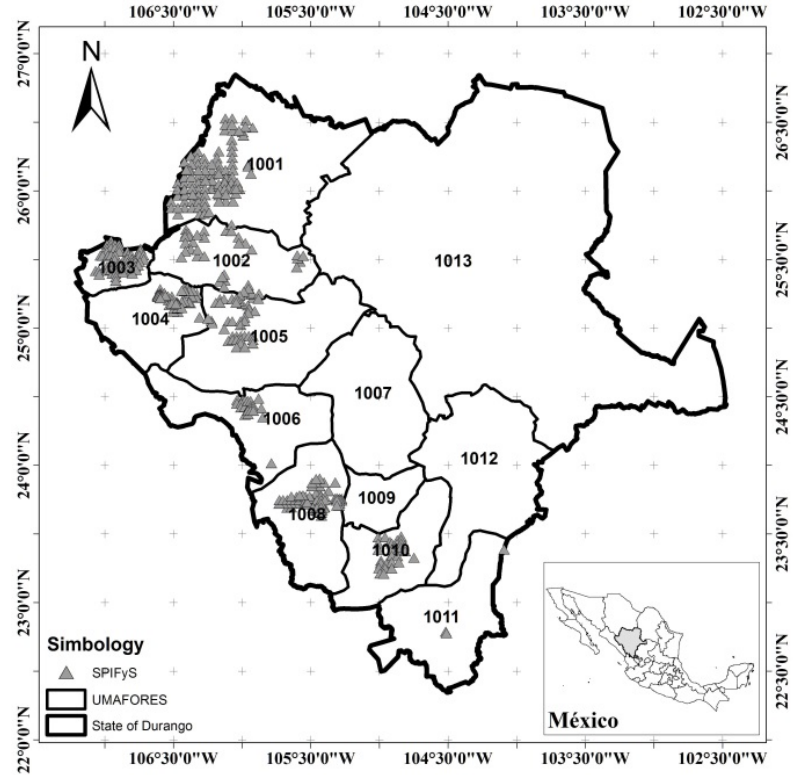
Figure 1. Location of the study area. Triangles indicate the location of the 429 permanent sampling